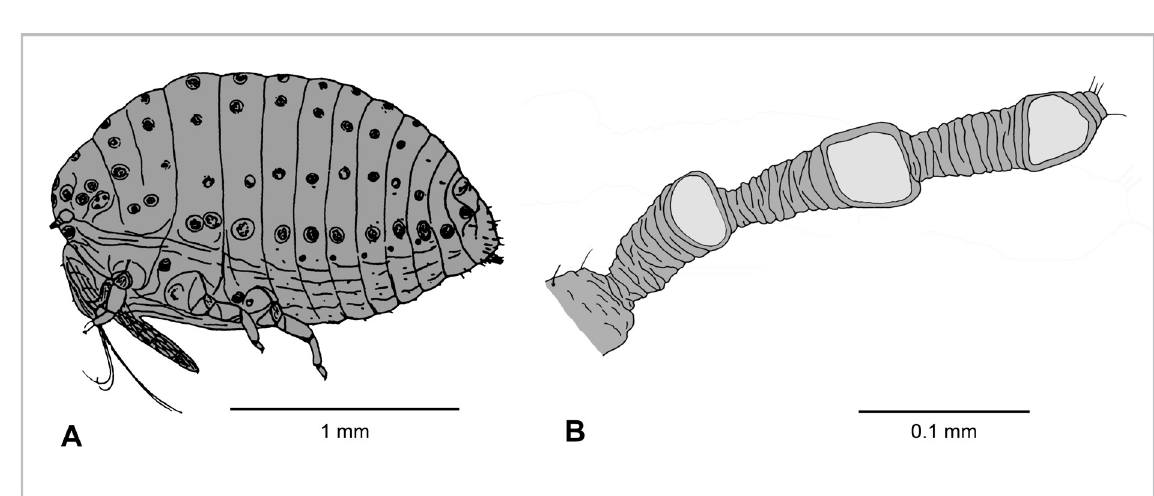
Fig. 21. Adelges (Sacciphantes) abietis (Linnaeus, 1758). A . Adult pseudofundatrix. B . Antenna of alate gallicola. (After Börner 1908, redrawn and modified.)